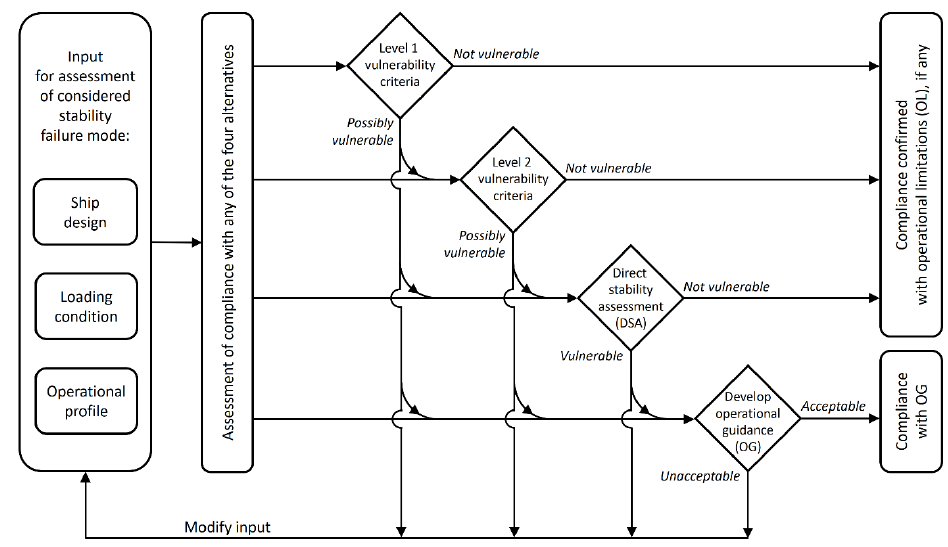
Figure 1. Application logic for IMO Second Generation Intact Stability guidelines